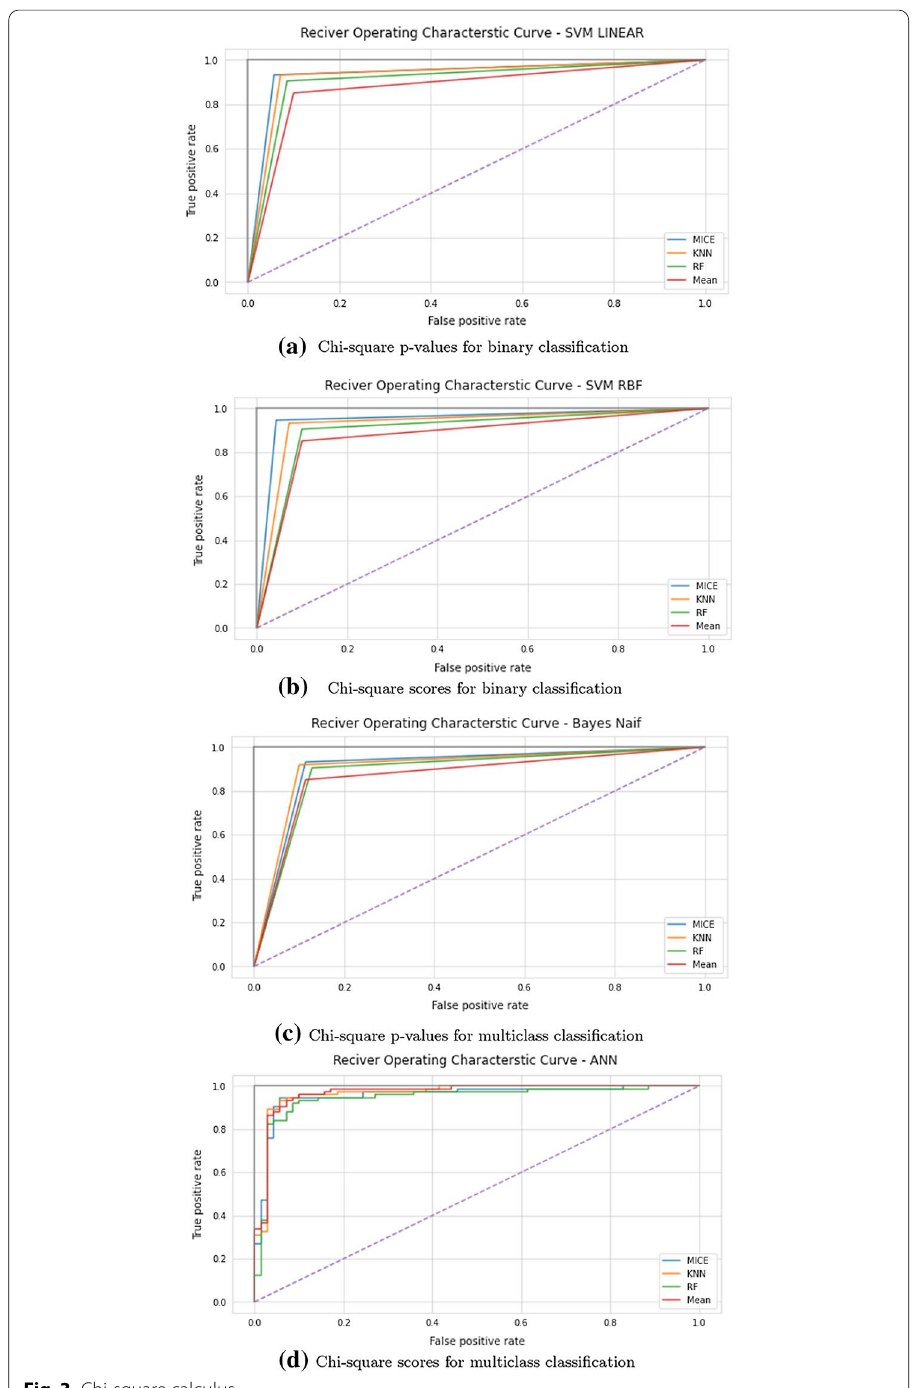
(Adaboost), Gradient Boosting, ExtraTrees,Light Gradient Boosting (Lightgbm), Sto- chastic Gradient Boosting (SGDC), and Nu SVM. The Table 3 describes the parameters of each